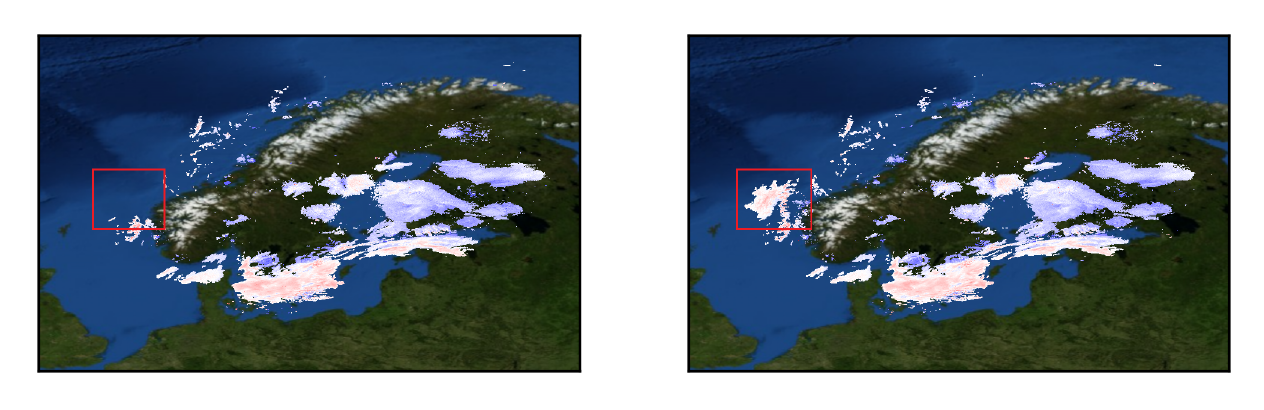
Figure 6. Actual composite reflectivity values on two consecutive acquisitions ( t —( left ) side image— and t + 1—( right ) side image) from MET